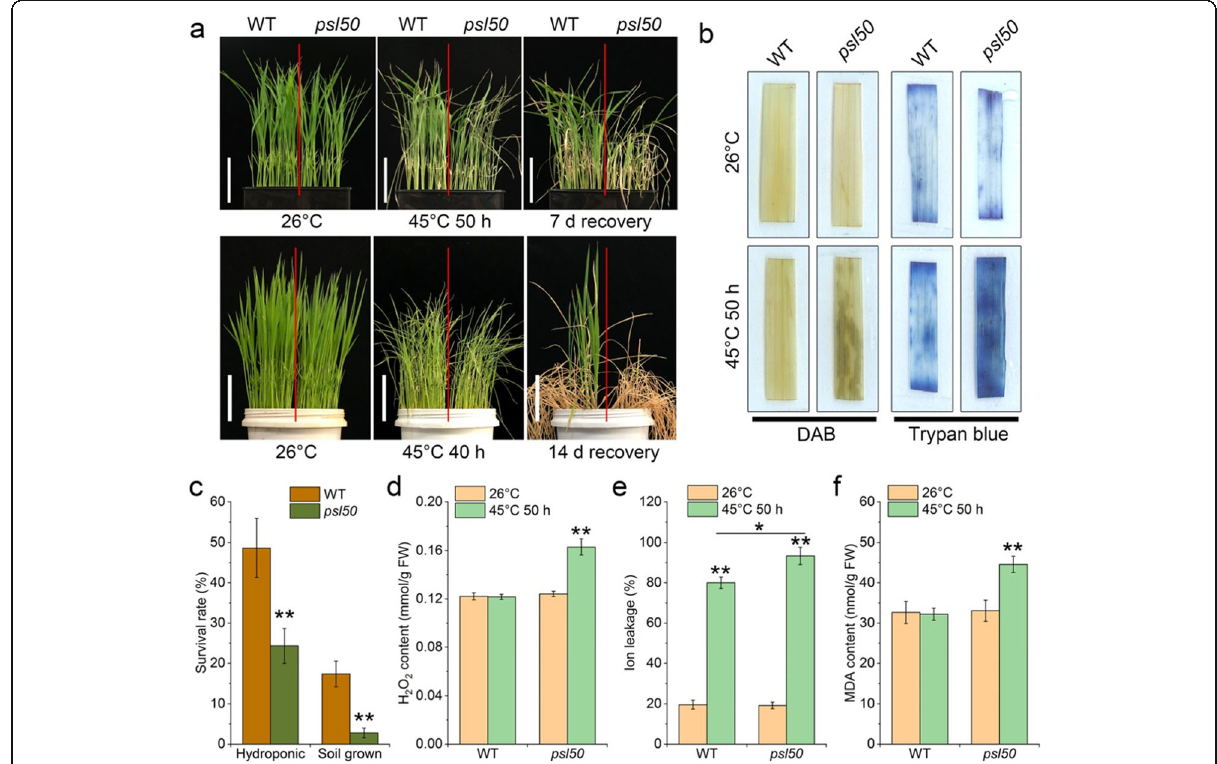
Fig. 2 Effects of heat stress on psl50 and WT at the seedling stage. a Phenotypes of WT and psl50 seedlings under heat stress. Seedlings were hydroponically (upper row) or soil grown (lower row) at 26 °C for 12 d and then treated at 45 °C for 50 h or 40 h followed a recovery at 26 °C. Scale bars = 5 cm. b DAB staining for H 2 O 2 accumulation detection and trypan blue staining for cell death detection in the top 2nd leaves of hydroponical seedlings before and after heat treatment. c Survival rate of hydroponic WT and psl50 seedlings shown in a . d-f H 2 O 2 content, ion leakage rate and MDA content in hydroponic WT and psl50 seedlings before and after heat treatment. Data are means ± SD ( n = 3). Asterisks indicate significant difference by Student ’ s t test (** P < 0.01 and * P <